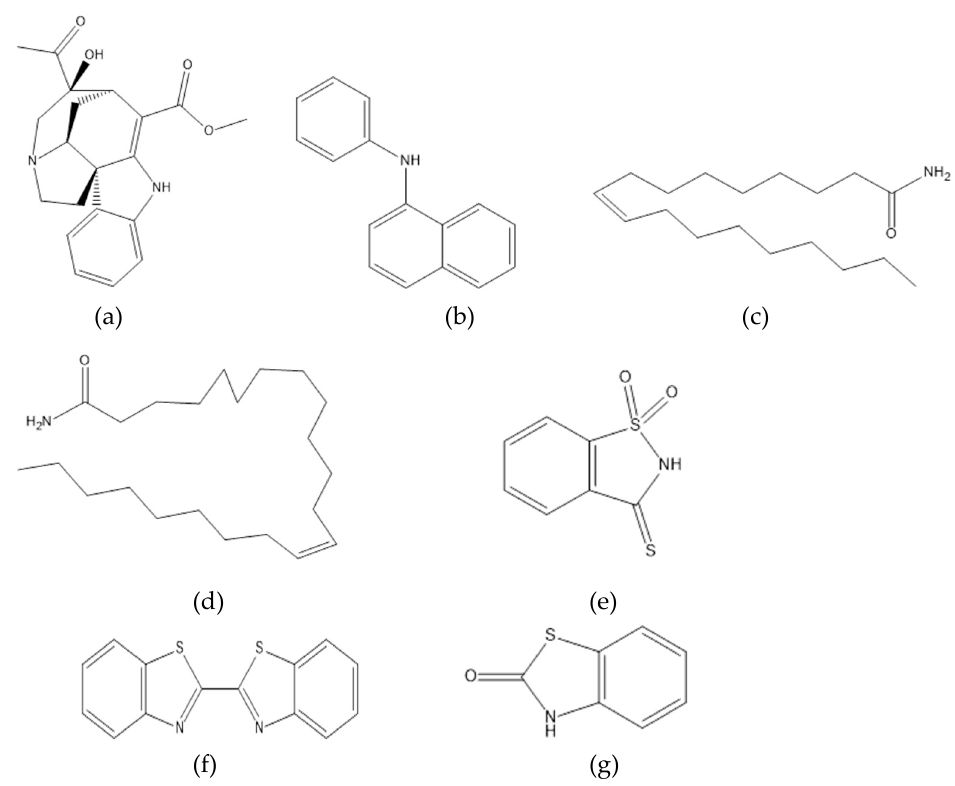
Figure 9. The structure of ( a ) Methyl 20-hydroxy-19-oxo-2,16-didehydrocuran-17-oate; ( b ) α - Naphthylphenylamine; ( c ) Oleamide; ( d ) Erucylamide; ( e ) 1,2-Benzisothiazoline-3-thione, 1,1-dioxide; ( f ) 2,2’-Bibenzothiazole; and ( g ) 2(3H)-Benzothiazolone.